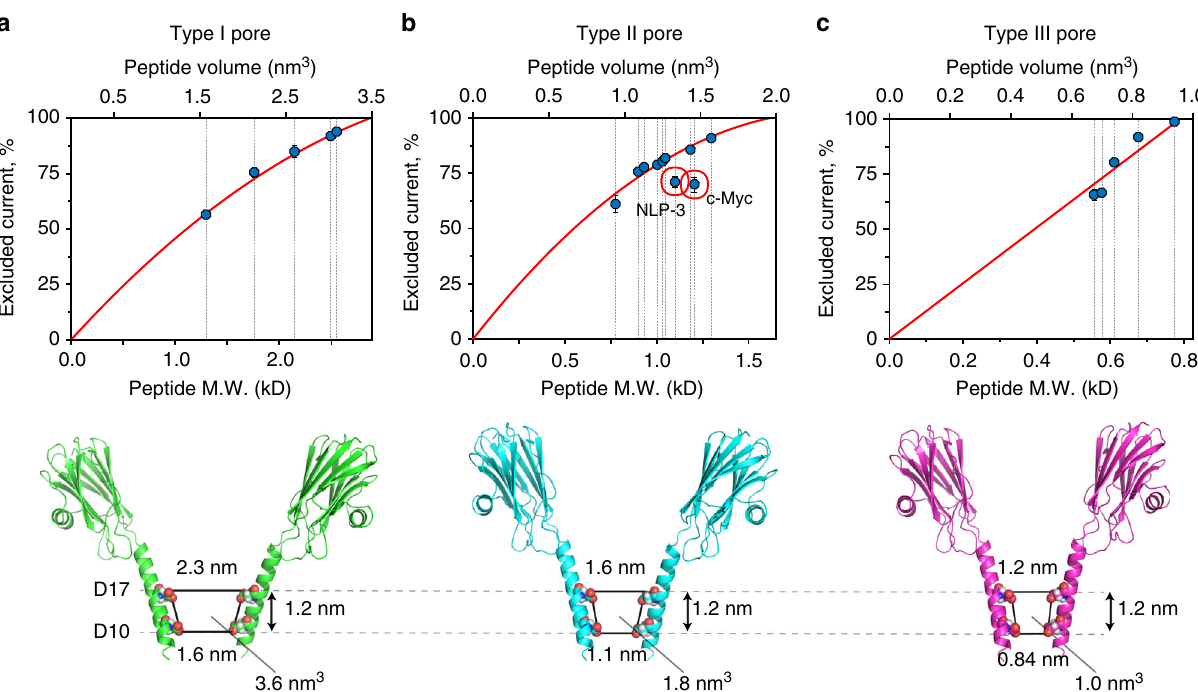
Fig. 4 Recognition of peptides with different chemical composition at pH 4.5. On the top graph is the relation between the molecular weight (M.W.) or volume of the peptide and the I ex% . The bottom fi gure shows the sensing volume of type I wild-type fragaceatoxin C (Wt-FraC) ( a ), type II W116S-FraC ( b ), and type III W112S-W116S-FraC ( c ) nanopores. The solid line represents a second order polynomial fi tting in a , b and a linear fi tting in c , with the extrapolated value at 100% I ex% corresponding to the volume of a peptide that would completely occupy the sensing volume of the nanopore. The latter is most likely constricted to the volume included between the constriction of the pore (aspartic acid 10) and the residues that lie one turn of a helix above the constriction (aspartic acid 17). The distances are measured from two opposing residues and include the van der Waals radii of the atoms. Current blockades were measured at − 30 mV for type I and II pore, and at − 50 mV for type III pore in 1 M KCl solutions. The error bars represent standard deviation from at least three repeats. Red circles highlight the two peptides that bare a negative charge at pH 4.5 (Table